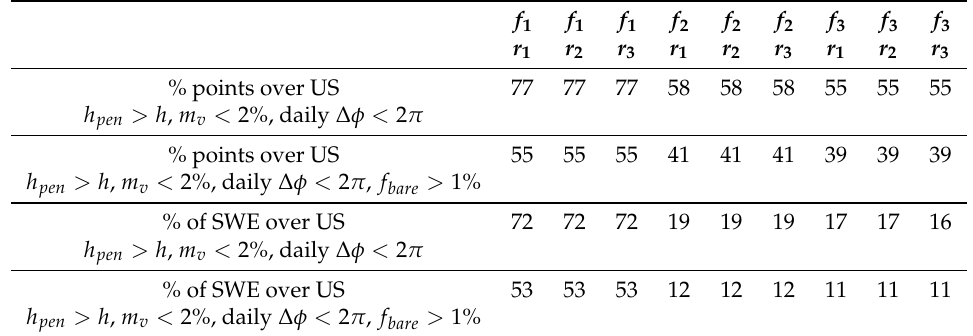
Table 3. US data satisfying the preconditions of differential interferometry retrieval method in 1997, ( f 1 = 1 GHz, f 2 = 13.5 GHz, f 3 = 17.25 GHz , r 1 = 0.2 mm, r 2 = 0.5 mm, r 3 = 0.8